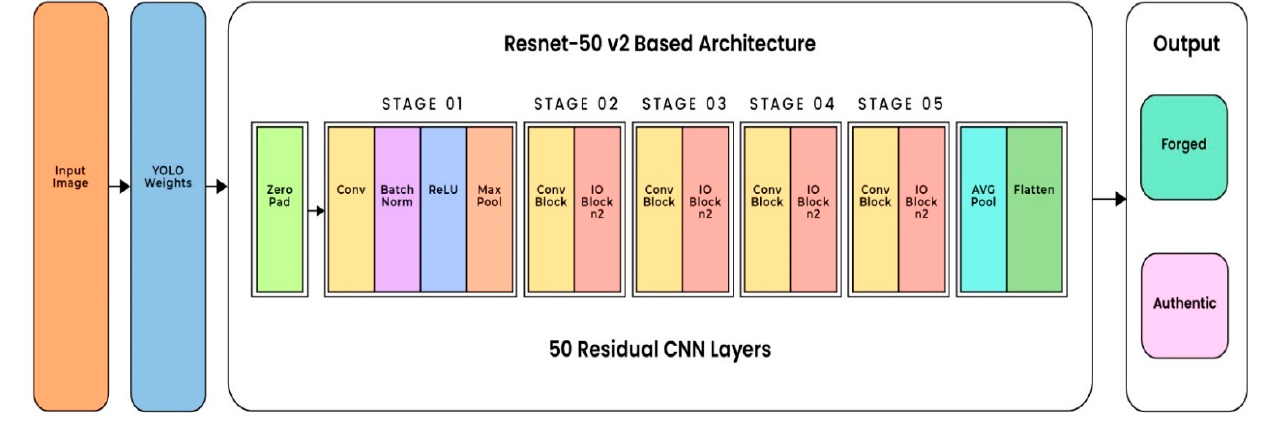
Figure 4. ResNet50v2-based architecture for proposed system.